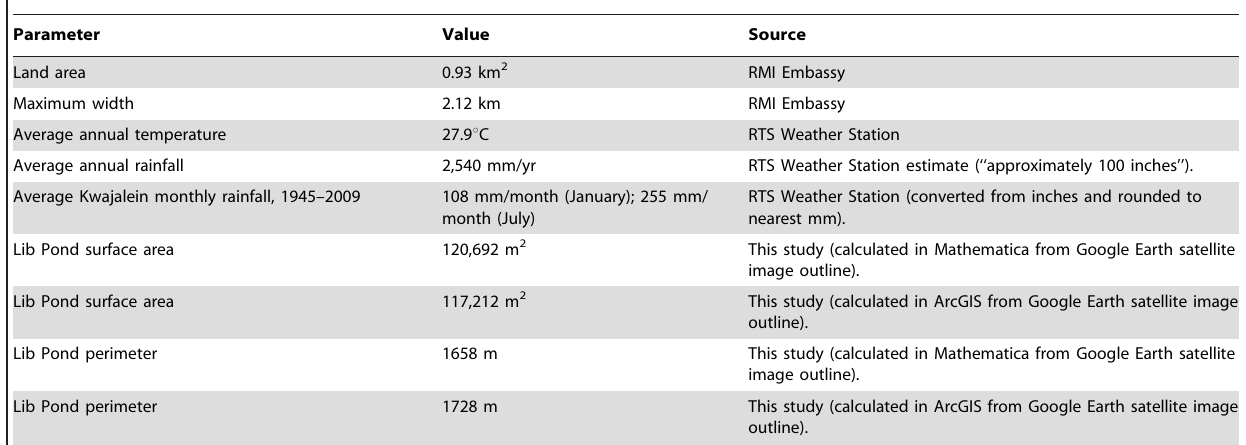
Table 1. Lib Island Profile Parameters.